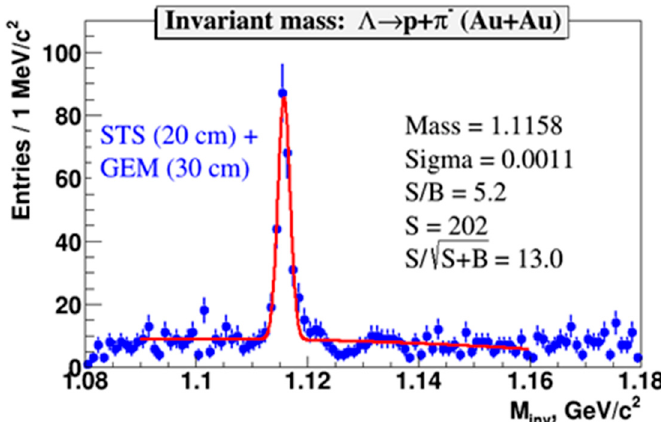
Figure 6. Proton–pion invariant mass spectra using the BM@N hybrid tracker.